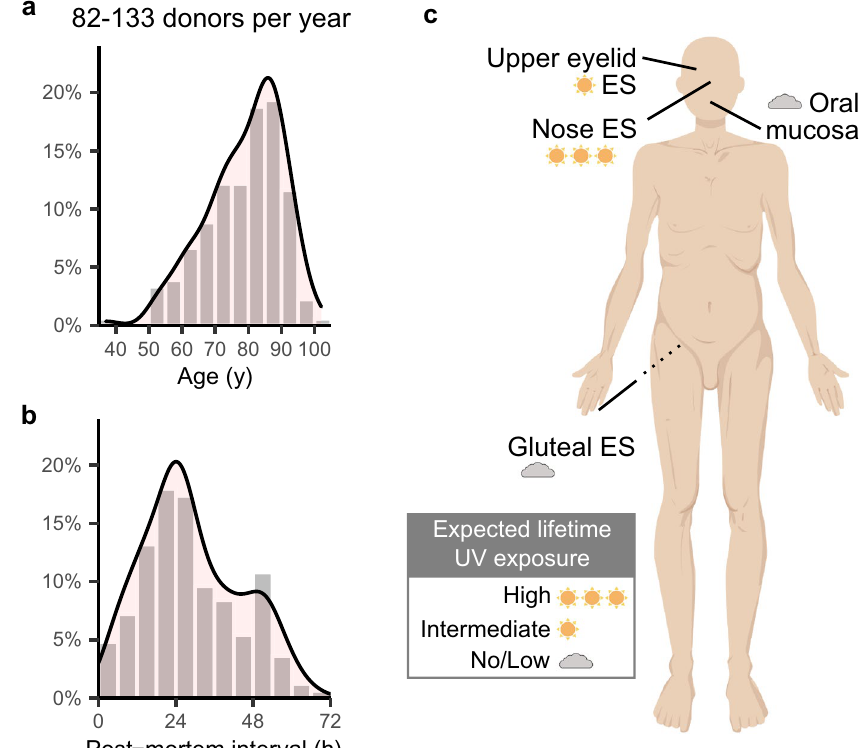
Figure 1. Detecting mutational clonality in post-mortem epithelial tissues derived from whole-body donors. ( a , b ) Histograms showing the distribution of ( a ) age and ( b ) post-mortem interval in the complete population of whole-body donors at the UGent Anatomy and Embryology unit (data 2016–2021). ( c ) Skin and oral tissues were sampled from 4 different locations as